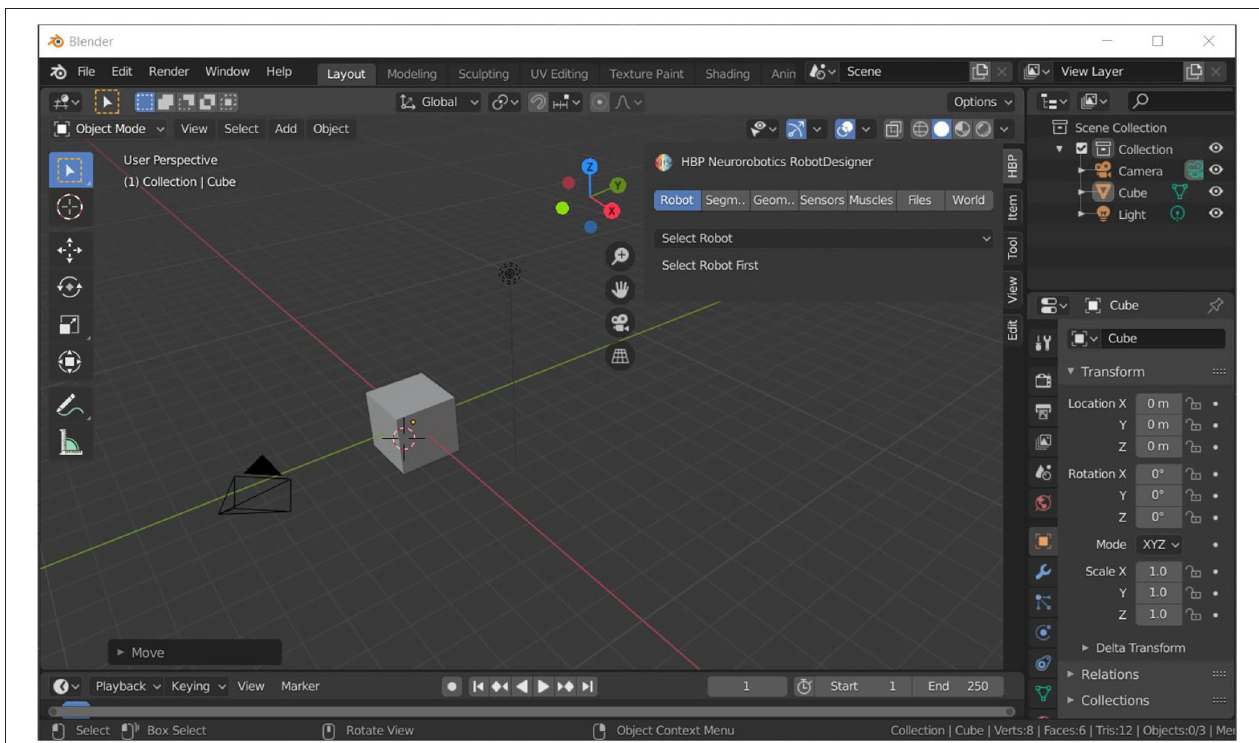
FIGURE 1 | Graphical User Interface (GUI) of the 3D modeling suite Blender. The Robot Designer is implemented as a plugin to extend the design tools for robot and musculoskeletal modeling, specifically it can be expanded from the menu as shown in the top-right area of the figure.